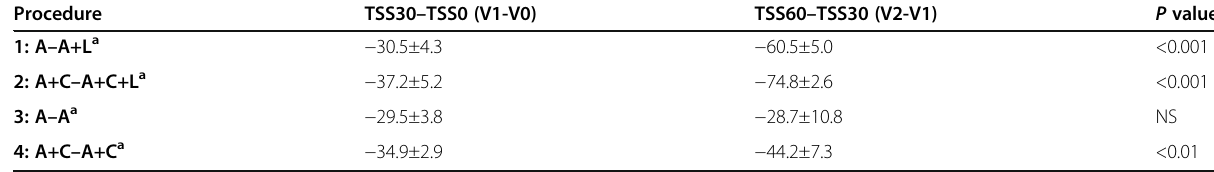
Table 3 Numerical presentation of differences in the percents of improvement in TSS (day 30 vs day 0; day 60 vs day 30) Procedure